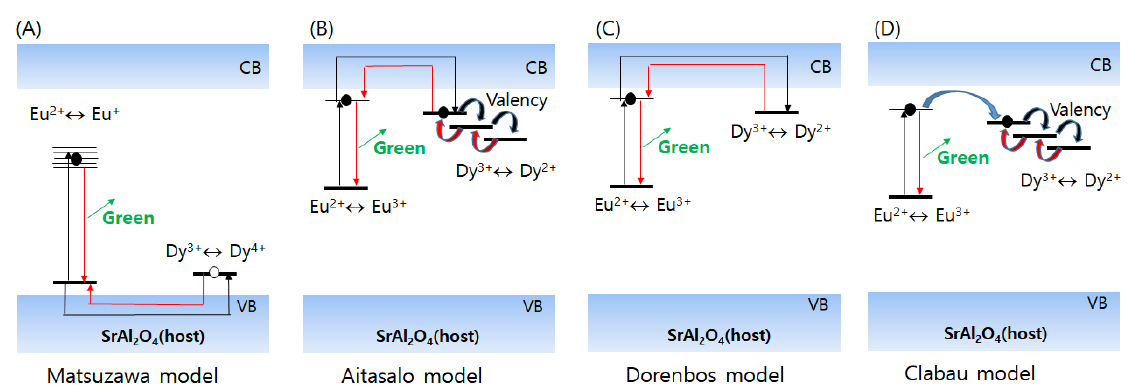
Figure 2. The ( A ) Matsuzawa, ( B ) Aitasalo, ( C ) Dorenbos, ( D ) Clabau models for the photoluminescence of SrAl 2 O 4 :Eu 2+ , Dy 3+ .